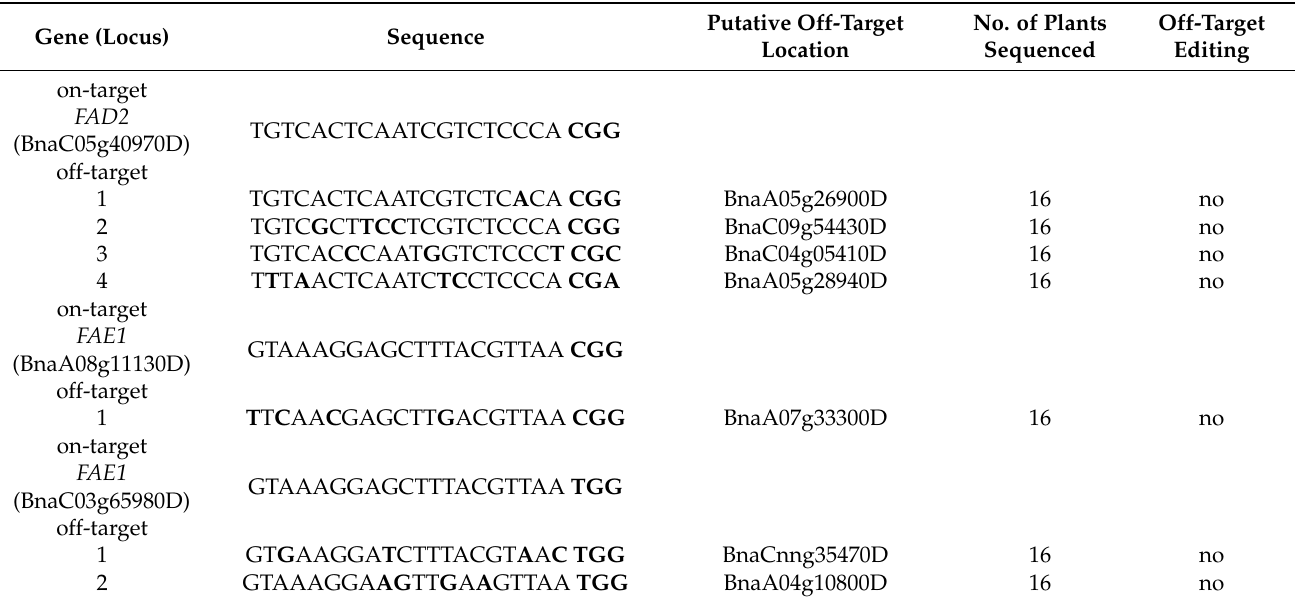
Table 2. Detection of putative off-target potential at each sgRNA target in T 0 edited plants.